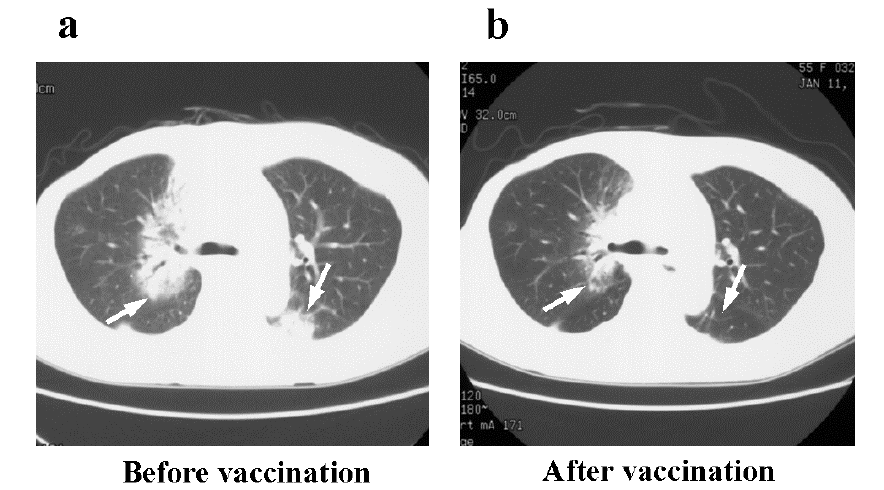
FIGURE 4. A representative case with solid cancer that showed clinical response to the WT1 peptide vaccination. This case is a breast cancer patient with lung metastasis. The metastatic tumors (indicated with arrows) detected before the vaccination (a) regressed after the vaccination (b). This figure was modified from that in Oka, Y. et al. (2004) Proc. Natl. Acad. Sci. U.S.A . 101, 13885– 13890. Copyright National Academy of Sciences,